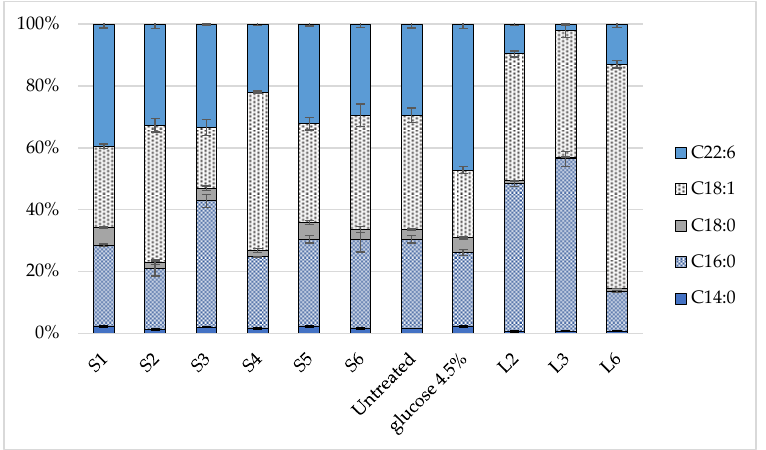
Figure 4. Fatty acid profile of oil extracted by C. cohnii cells after 120 h of cultivation on biomass- derived sugars.